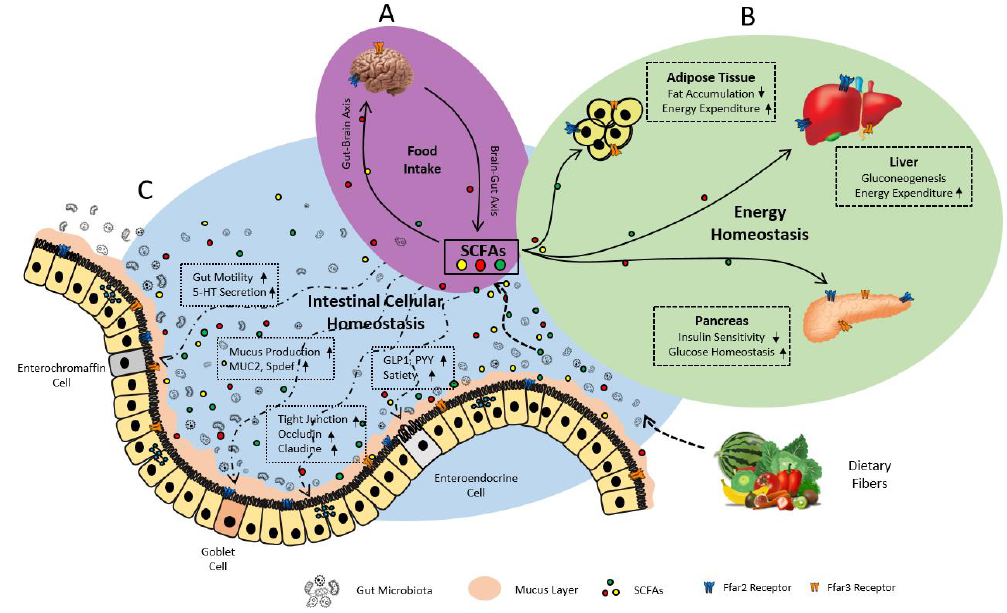
Figure 7. Role of diet-derived SCFAs activated FFAR2 / 3 signaling in regulation of energy balance through ( A ) Regulating the food intake by modulating gut-brain axis ( B ) Maintaining homeostasis by decreasing the fat accumulation and increasing the energy expenditure in adipose tissues, manipulating rate of gluconeogenesis in liver, and increasing insulin secretion and beta-cell function in the pancreas ( C ) Maintaining intestinal cellular homeostasis by increasing gut transit, mucus production, tight junction protein expression, and gut hormone synthesis and secretion.